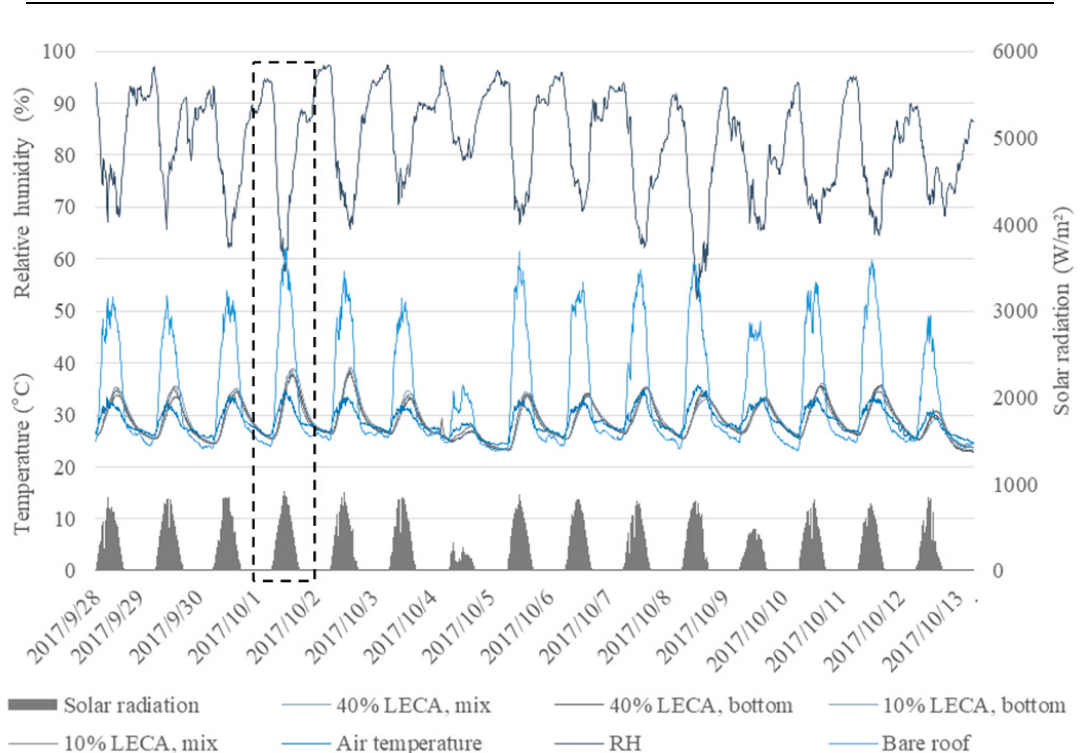
Date selected for further analysis (marked with dotted box)